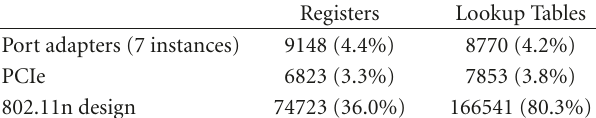
Table 3: FPGA resources (total and relative to available).